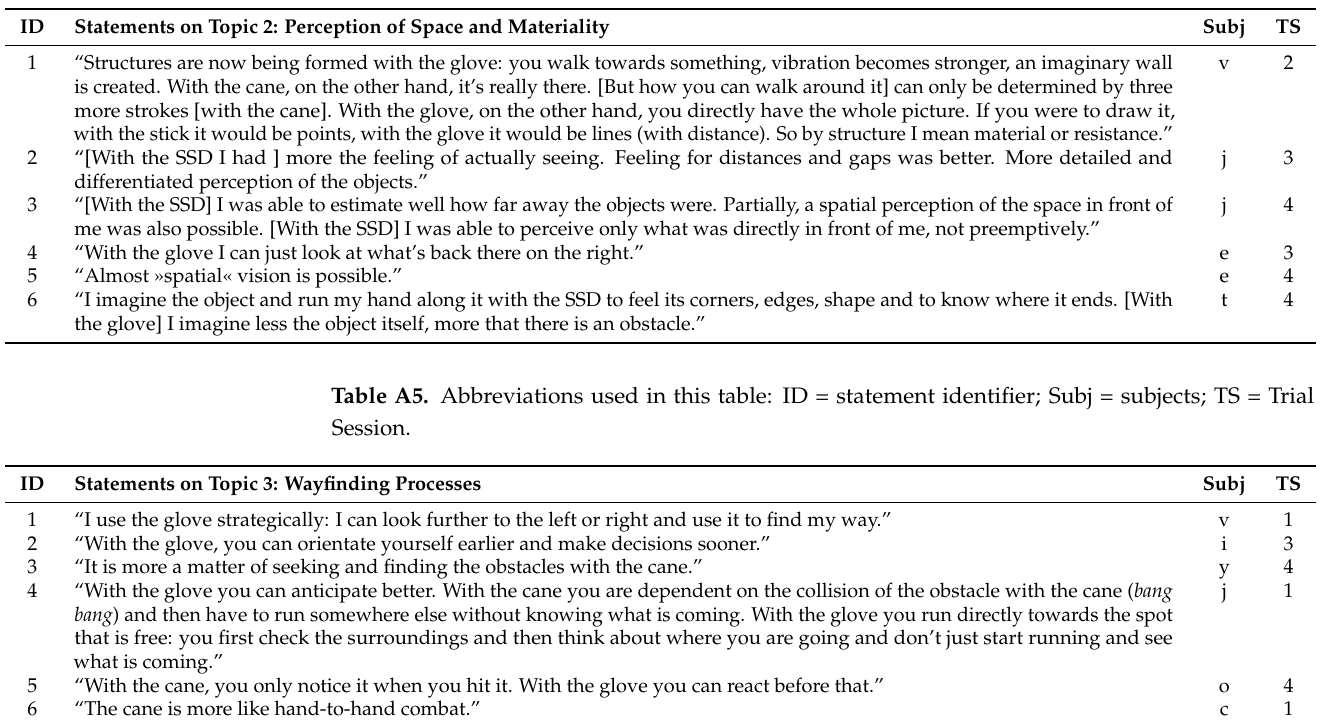
Table A4. Abbreviations used in this table: ID = statement identifier; Subj = subjects; TS = Trial Session.